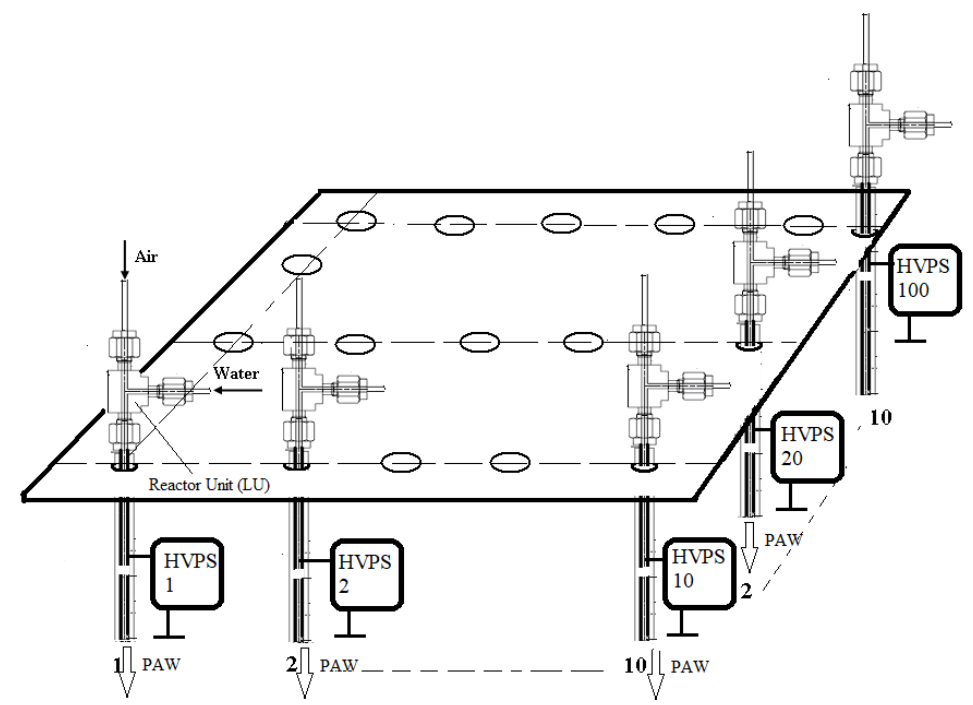
Figure 7. The schematic of multi-NTP reactor array powered by induction coil driven power sup- plies (ICR).